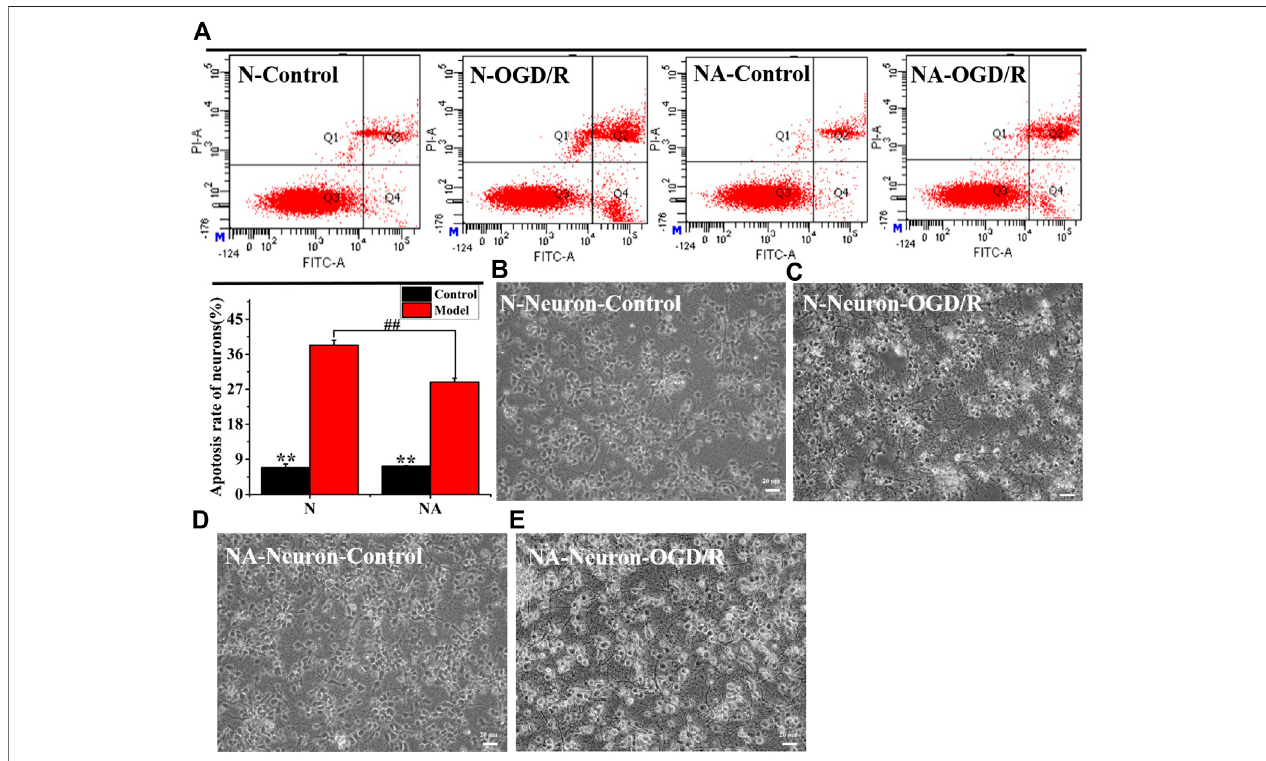
FIGURE3 | Neuronal apoptosis and morphology inN and NAgroups. (A) Neuronapoptosis in theN and NA groups. (B) Neuronal morphology in theN group. (C) Neuronal morphology inthe Ngroupafter OGD/R. (D) Neuronal morphologyin theNAgroup. (E) Neuronal morphology inthe NAgroup after OGD/R. ** p < 0.01, vs. the model group; ## p < 0.01, N vs. the NA